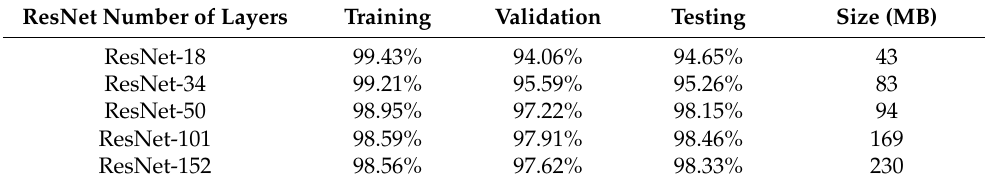
Table 4. Evaluation of the ResNet layers using the three performance measures (training, validation, and testing).